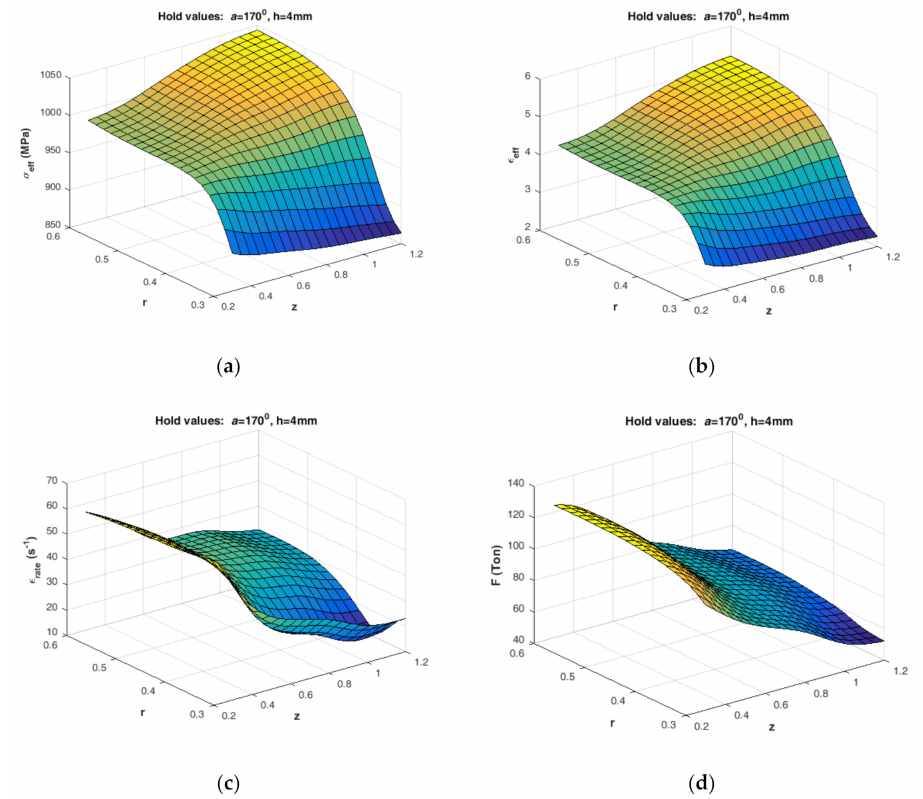
Figure 11. Interaction e ff ect of billet size and reduction ratio on forming behavior: ( a ) e ff ective stress; ( b ) e ff ective strain; ( c ) e ff ective strain rate; ( d ) punch